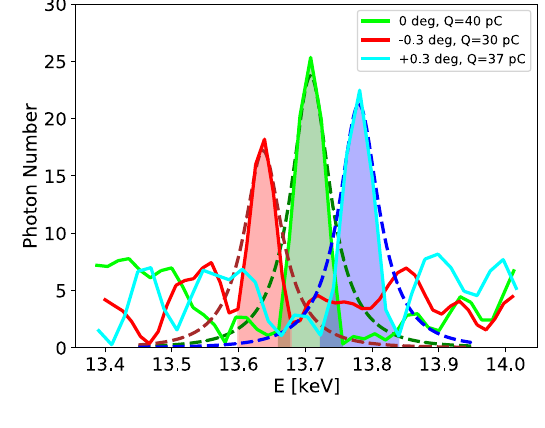
FIG. 6. Fine-tuning of PXR.